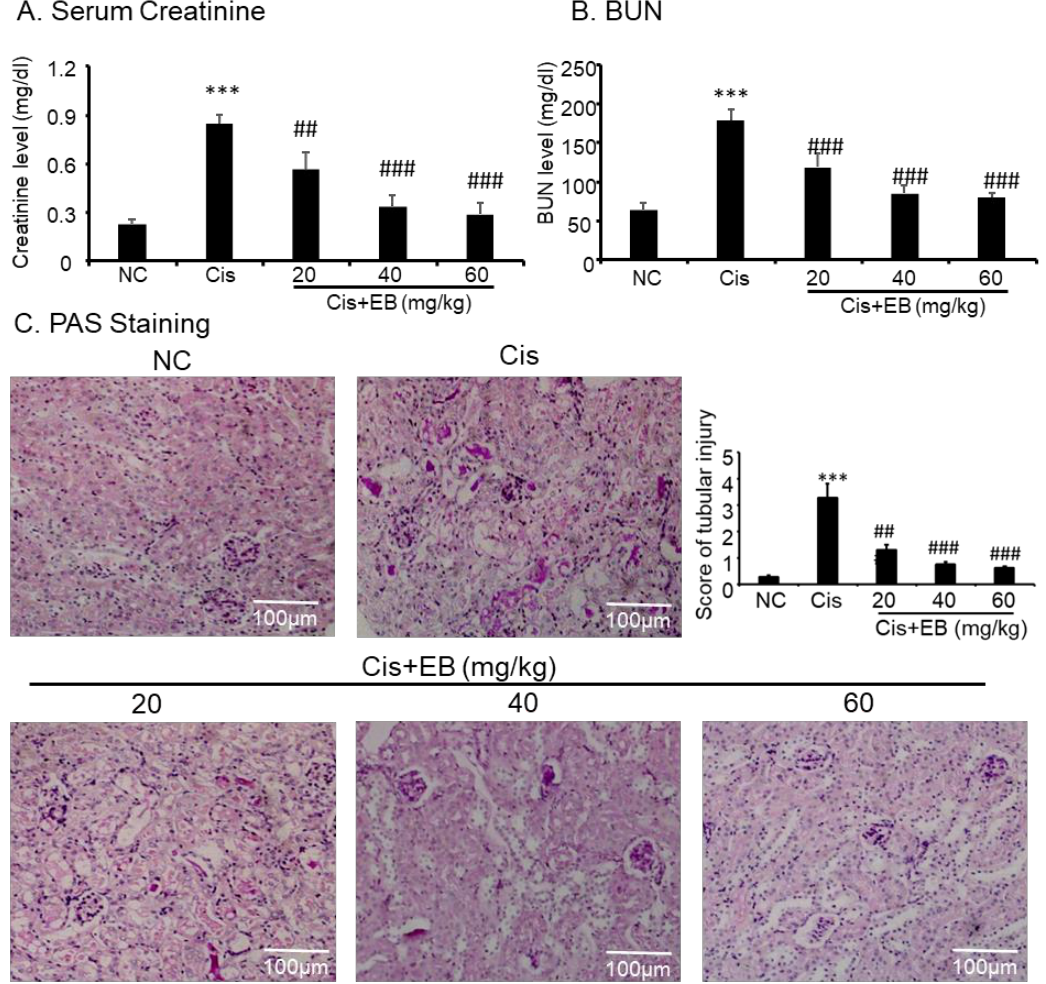
Figure 4. Changes in the levels of ( A ) serum creatinine, ( B ) blood urea nitrogen (BUN), and ( C ) histopathology after an intraperitoneal injection of cisplatin (20 mg/kg). Saline or eleutheroside B was injected 30 min before the injection of cisplatin. Each column represents the mean ± SD (n = 4 – 7). Results of serum creatinine and BUN show that treatment of eleutheroside B (20, 40, 60 mg/kg) restored renal function in cisplatin nephropathy. C: periodic acid-Schiff (PAS) staining and score. Results of PAS staining and score of severity indicate that treatment with set concentrations of eleutheroside B (20, 40, 60 mg/kg) alleviated tubular necrosis, tubular dilation, and cast formation in cisplatin nephropathy. Data are mean ± SEM for 6 – 8 mice. * p < 0.05, ** p < 0.01, *** p < 0.001 compared to normal; # p < 0.05, ## p < 0.01, ### p < 0.001 compared to model. Cis, cisplatin; EB, eleutheroside B. KIM-1: kidney injury molecule-1. Magnification, 20×.